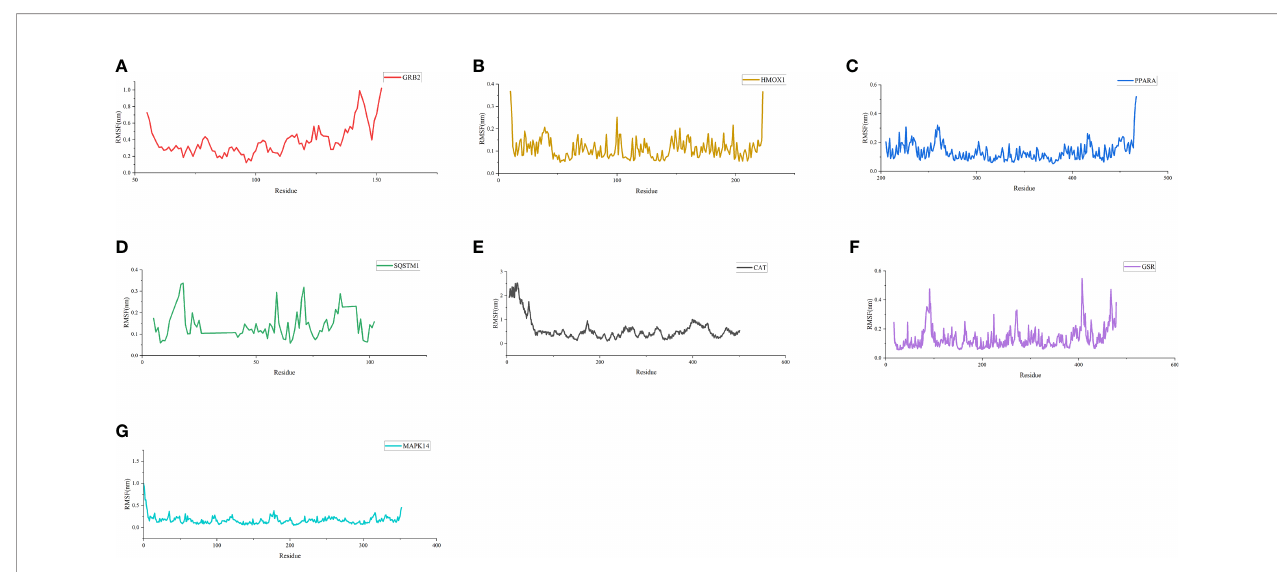
FIGURE 7 | RMSF of residues. (A) RMSF of GRB2-CoQ10 complex. (B) RMSF of HMOX1-CoQ10 complex. (C) RMSF of PPARA-CoQ10 complex. (D) RMSF of SQSTM1-CoQ10 complex. (E) RMSF of CAT-CoQ10 complex. (F) RMSF of GSR-CoQ10 complex. (G) RMSF of MAPK14-CoQ10 complex.